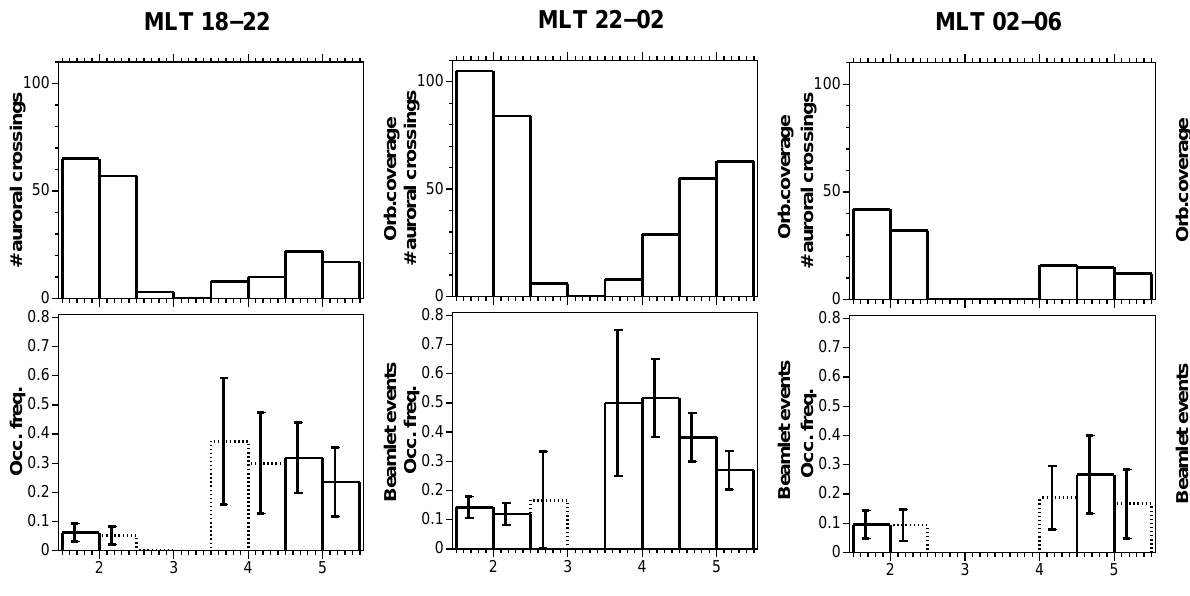
Fig. 2. Top panels in each subplot show the orbital coverage of the Polar satellite, i.e. the number of good auroral crossings where “good” means that a clear polar cap boundary was seen in TIMAS data. Second panels show the occurrence frequency of ion beamlets by as a function of altitude, for K p ≤ 2 (filled dots) and for K p > 2 (triangles). Each subplot shows the occurrence frequency for 18–22, 22–02 and 02–06 MLT respectively.